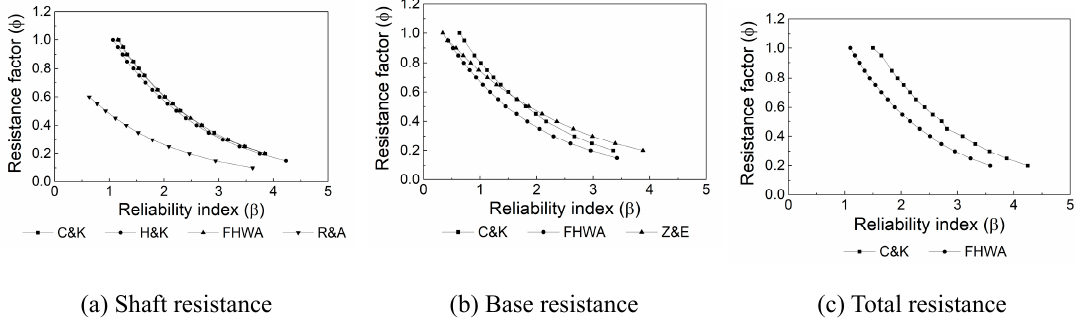
Figure 10. Relationship between the reliability index and the resistance factors for each component. Table 11. Results for the resistance factors. (a) Shaft resistance.